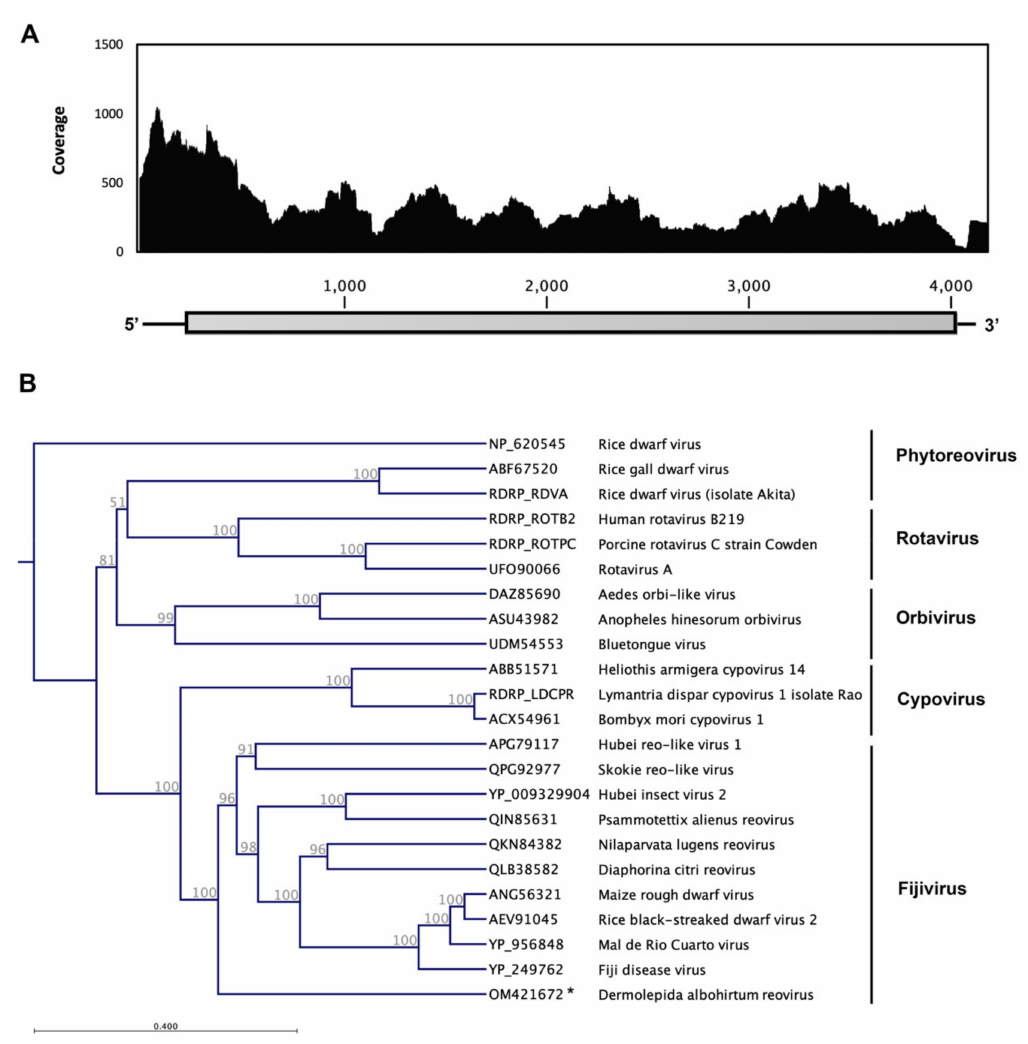
Figure 4. Schematic of the genome organization and coverage of Dermolepida albohirtum reovirus (DaRV). RNA-Seq read density plotted along the viral genome. The Y -axis shows the number of reads mapped to a particular nucleotide of the virus genome at the X -axis ( A ). The maximum likelihood phylogeny of novel member of the Reoviridae family, which identified in D. albohirtum (DaRV) and previously reported viruses in the Reoviridae family based on deduced amino acid sequence of conserved RdRP domain. The identified virus in this study is shown with an asterisk ( B